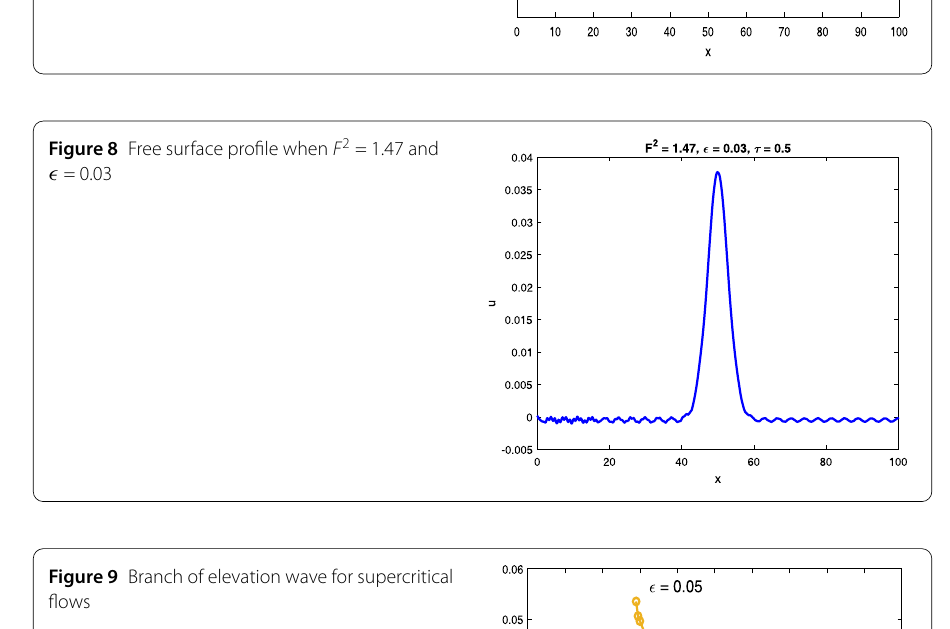
Figure 9 Branch of elevation wave for supercritical